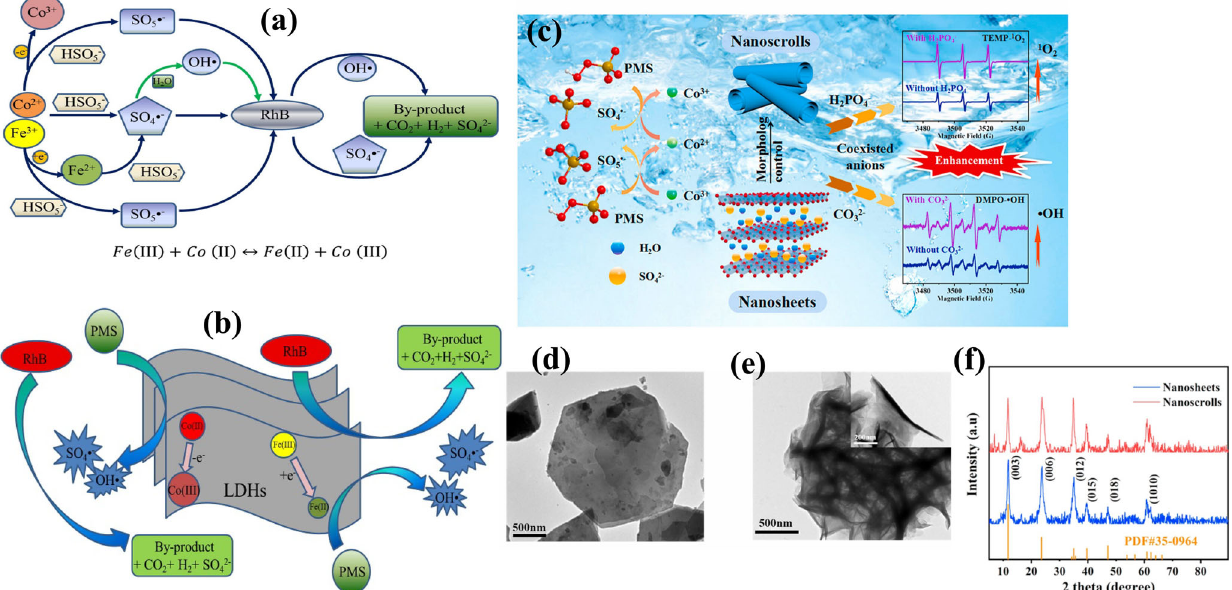
Fig. 8 The PMS activation by LDHs-based catalysts and the structure characterization of LDHs. a The degradation mechanism of RhB, b the PMS activation by CoFe-LDH adapted with permission from ref. 153 , Copyright, 2022, Elsevier. c The schematic diagram of MgCoAl-LDH nanosheets and nanoscrolls, d TEM of MgCoAl-LDH nanosheets, e TEM of MgCoAl-LDH nanoscrolls, and f XRD of MgCoAl-LDH nanosheets and nanoscrolls adapted with permission from ref. 160 , Copyright, 2022,